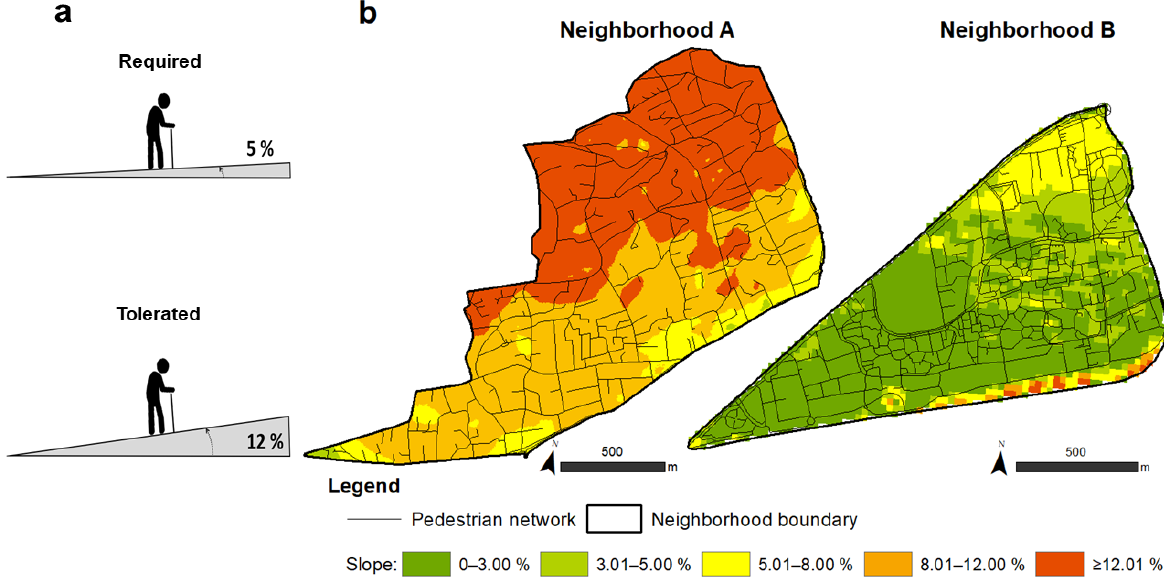
Figure 3. Gradients. ( a ) Representation of the statutory and tolerated gradients according to France’s accessibility regulations. ( b ) Modeling gradients in percent. Maps created by the authors with ArcGIS 10.4.